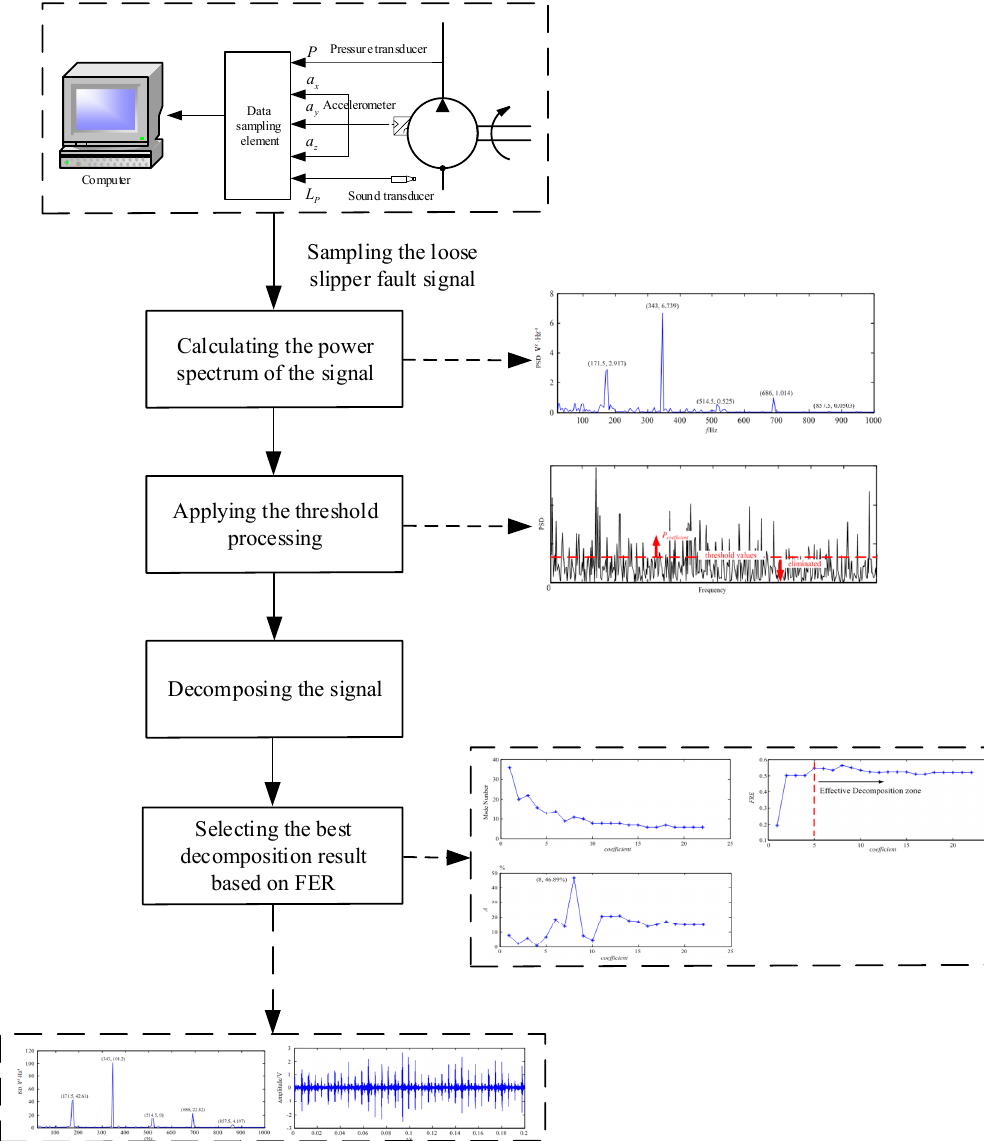
Figure 3. The flowchart of improved empirical wavelet transform (IEWT).